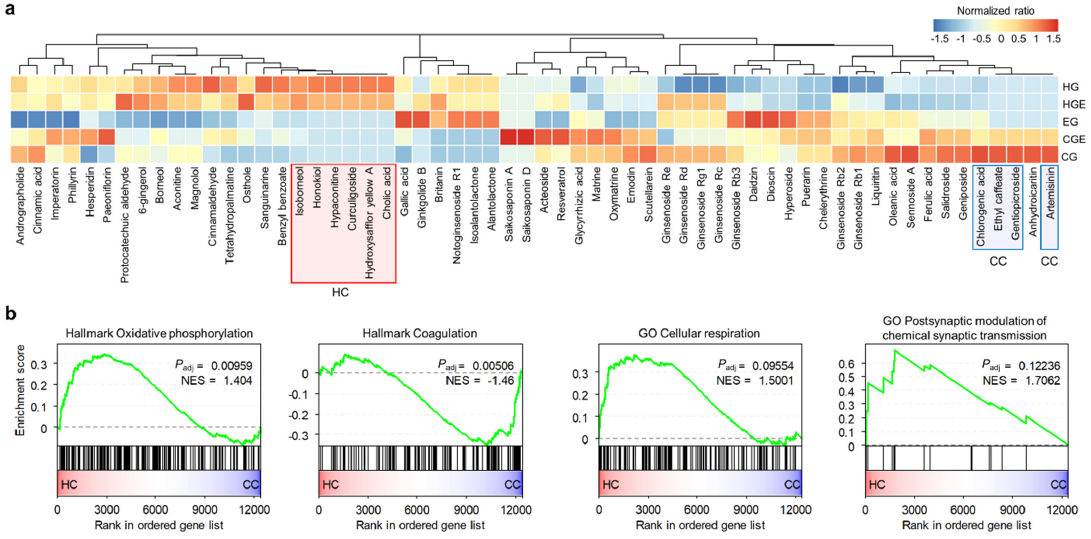
Figure 5. Transcriptomic analysis of the ingredients of the hot and cold groups. ( a ) Normalized ratios of ingredients included in the CG, CGE, EG, HE, and HG of the analyzed gene expression data, calculated as z-scores. The selected hot components (HC) and cold components (CC) are denoted with red and blue boxes, respectively. ( b ) Comparison of the GSEA results of HC and CC using Hallmark and GO BP gene sets. NES; normalized enrichment score.